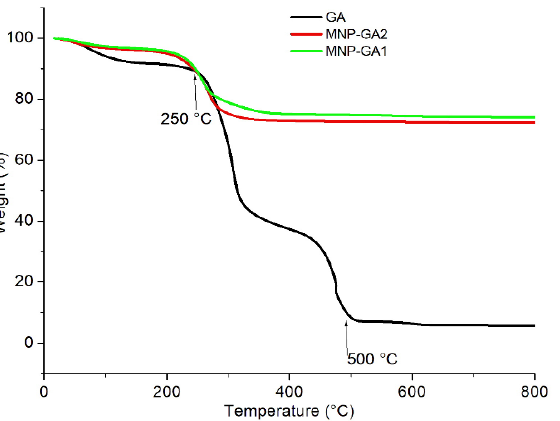
Figure 3. FT-IR spectra of the Fe 3 O 4 MNPs (green line), GA (blue line), MNP-GA2 (red line), MNP- GA1 (dark line).